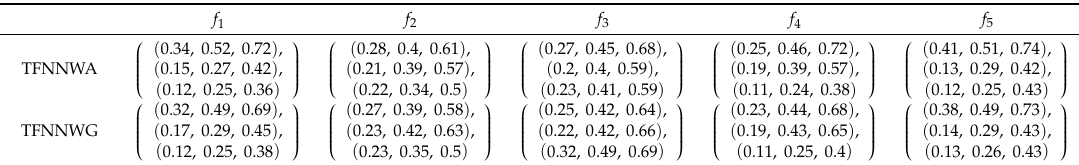
Table 10. The overall alternative values by using some TFNNs aggregation